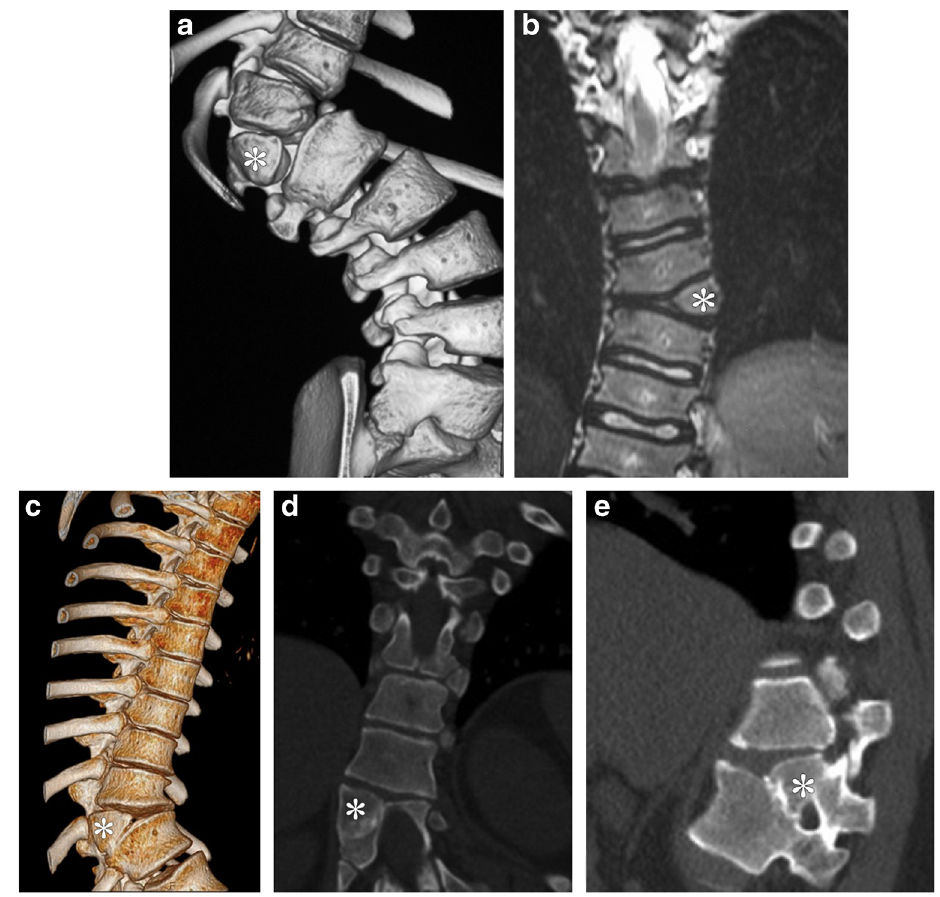
Fig. 8 a - b : Segmented hemivertebra in two patients: The 3D reconstruction from a non- contrast CT of the spine ( a ) and coronal T1-weighted MR image of different levels of the thoracic